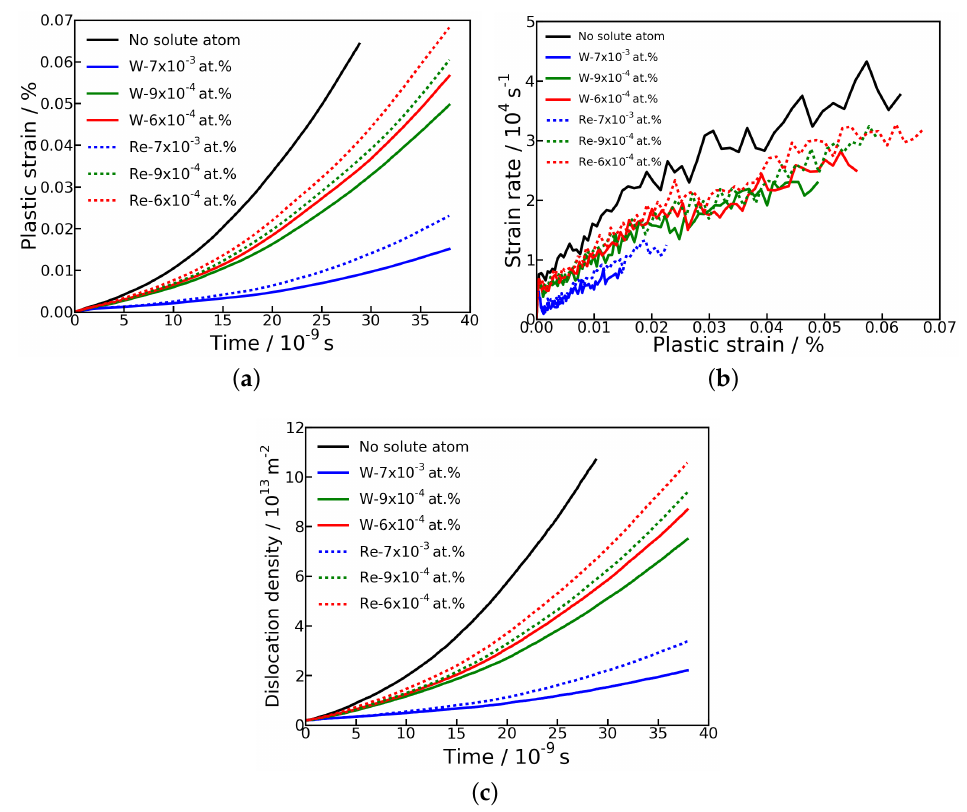
Figure 4. ( a ) Plastic strains as a function of time; ( b ) strain rates as a function of plastic strain; and ( c ) total dislocation densities as a function of time for the addition of Re and W with different concentrations under 500 MPa tensile load along [001] direction at 850 ◦